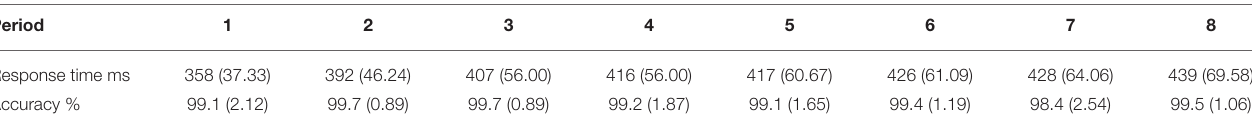
TABLE 1 | Descriptive statistics (M; SD ) for each time period of the cognitive task.